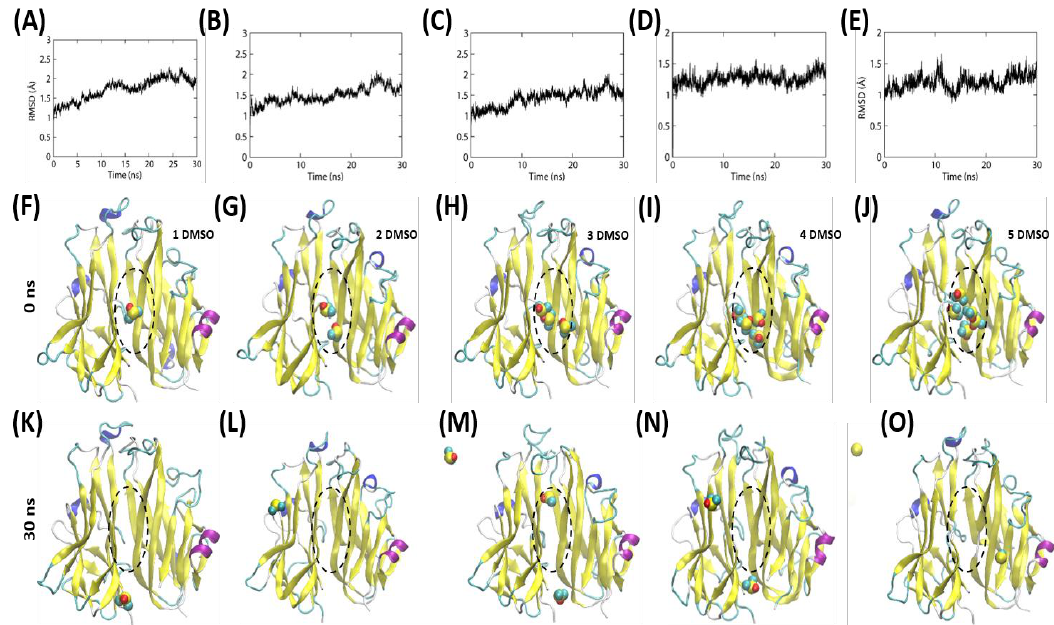
Figure 4. Molecular dynamics (MD) simulation of TNF and different numbers of DMSO molecules in its ligand-binding cavity. ( A – E ) Root mean square deviation (RMSD) of the backbone atoms. ( F – J ) The starting conformations of the TNF homodimer with different numbers of DMSO molecules in the ligand-binding site. ( K – O ) The final snapshot structure of the TNF–DMSO complex after a 30 ns MD simulation.